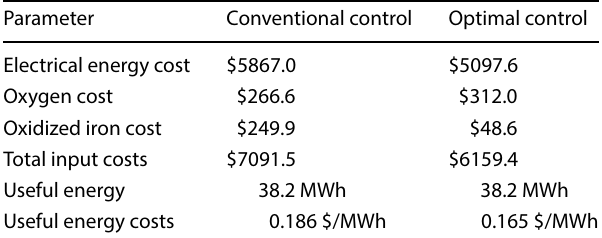
Table 4 Comparison between conventional and optimal